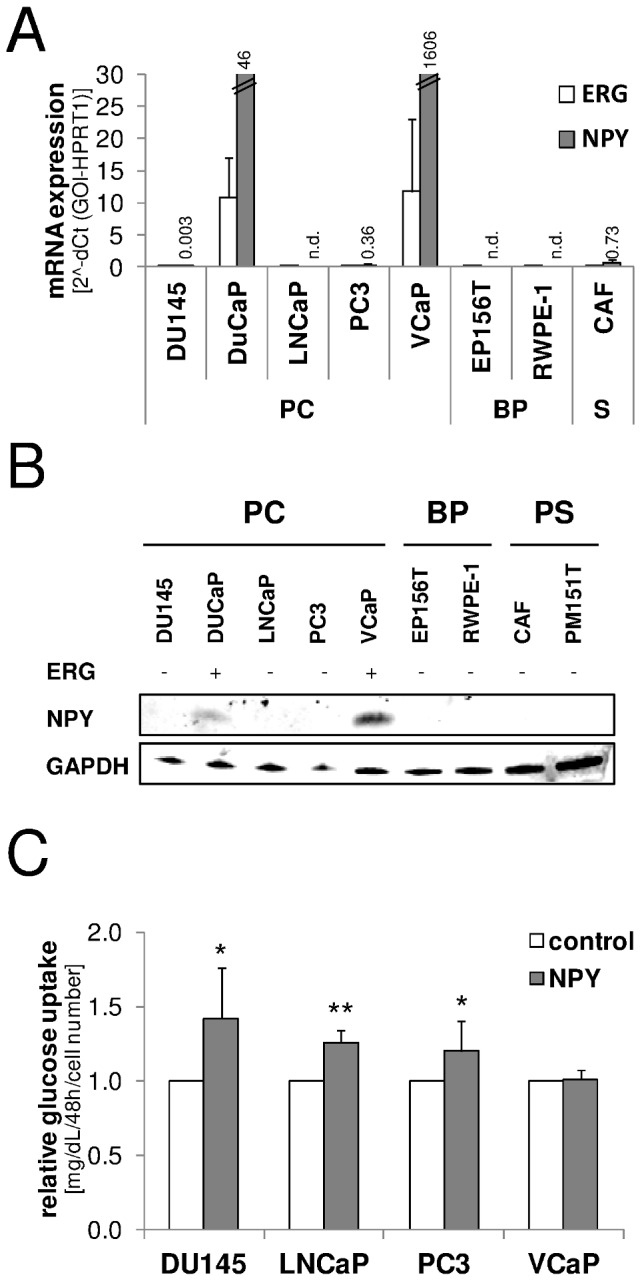
Neuropeptide Y (NPY) is up-regulated in ERG+ prostate cancer cell lines and increases glucose uptake.NPY was measured by qPCR (A) and immunoblot (B) in prostate cell lines. NPY expression was highest in ERG+ DuCAP and VCaP prostate cancer cells. C) NPY stimulation (48 h, 25 nM) increased glucose uptake in prostate cancer cells that do not express endogenous NPY (DU145, LNCaP, PC3). PC, prostate cancer cell lines; BP, benign prostate cell lines; PS, prostate stromal cell lines.